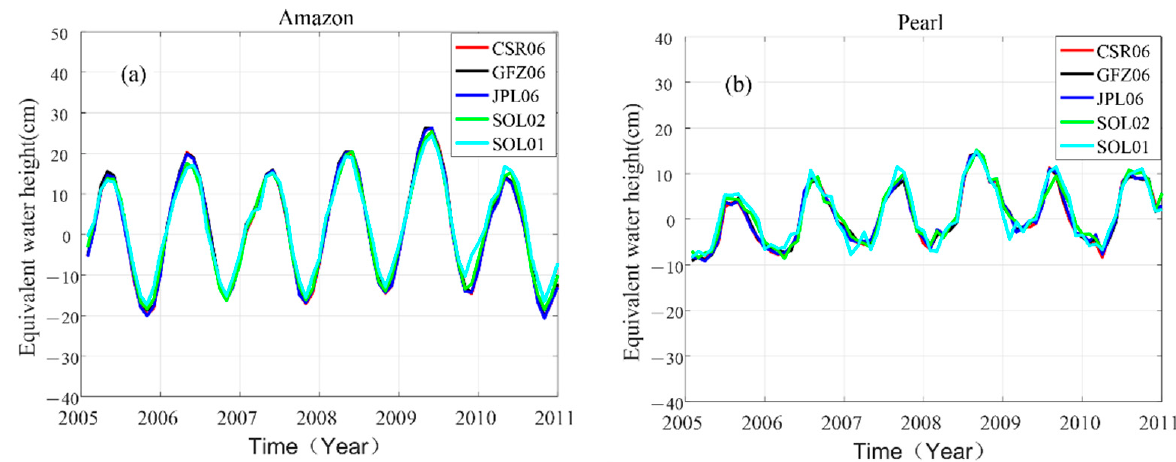
Figure 10. Water storage changes in the ( a ) Amazon and ( b ) Pearl River basins calculated based on GRACE monthly solutions from SOL01, SOL02, GFZ06, JPL06, and CSR06 (equivalent water column height in cm).